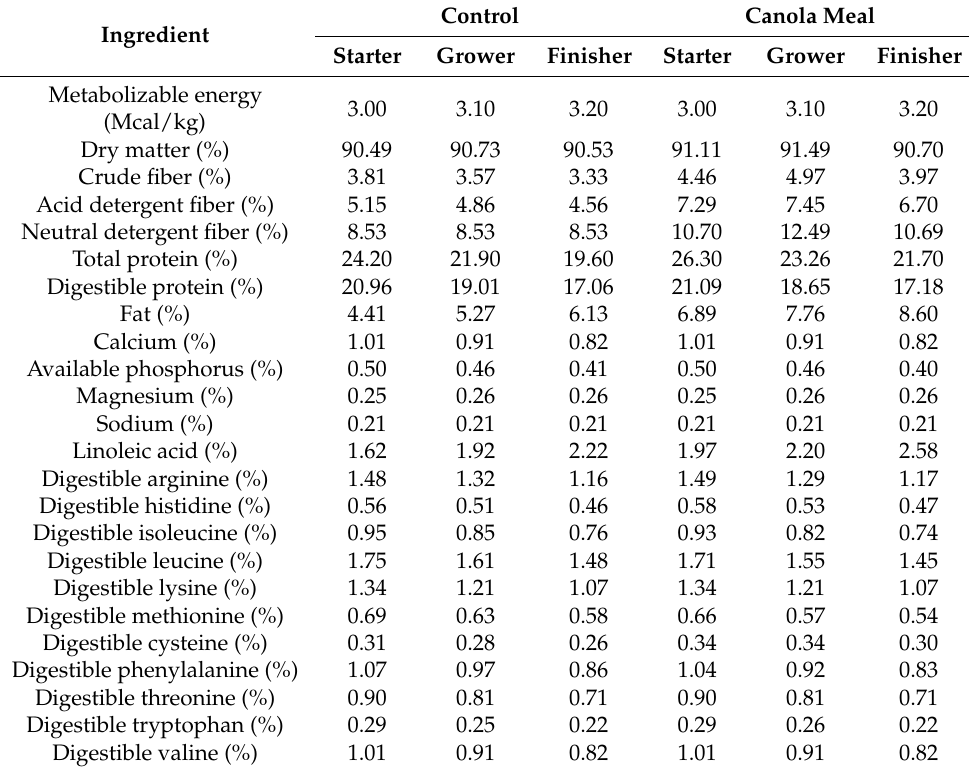
Table 2. Nutrient analysis of the control and canola meal broiler diets.